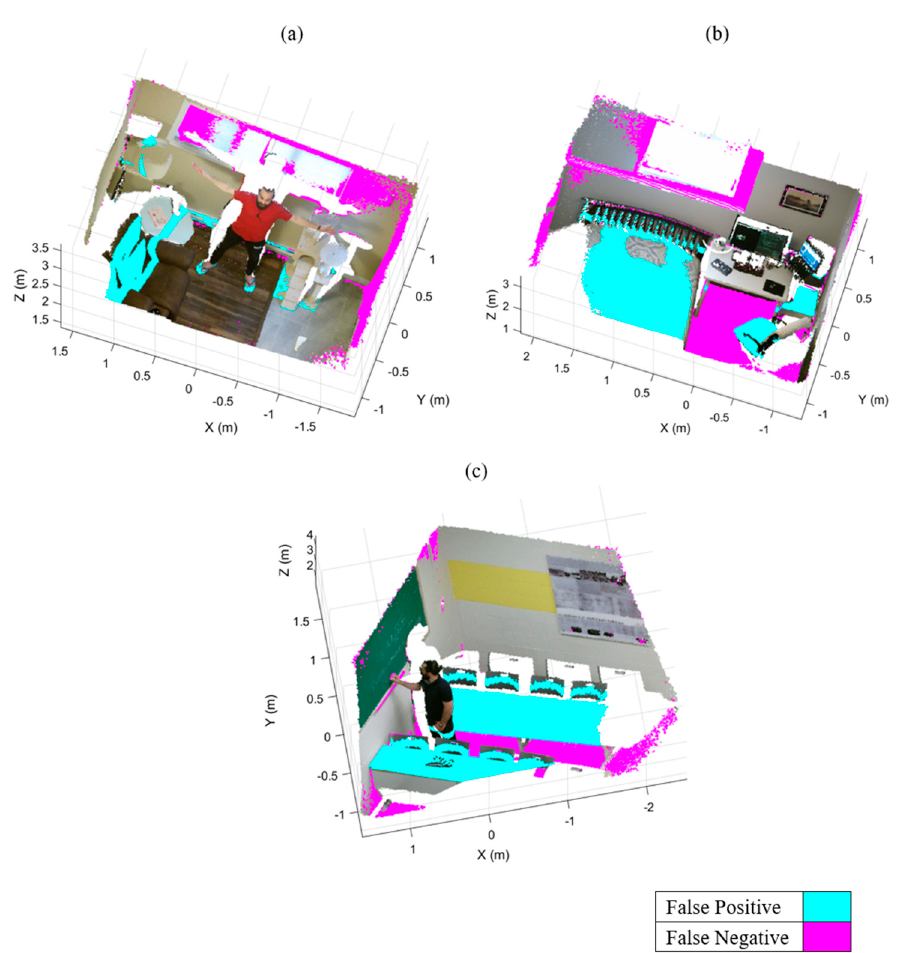
Figure 9. The output results of standard RANSAC plane removal and its false positives and false negatives in cyan and magenta, respectively: ( a ) the Room ‐ 1, ( b ) the Room ‐ 2, and ( c ) the Room ‐ 3.